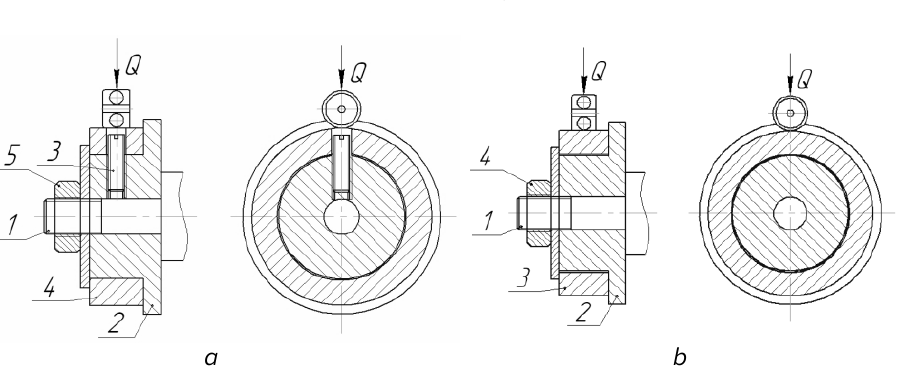
Fig. 3. Working unit of the installation: a - with a key; b -without